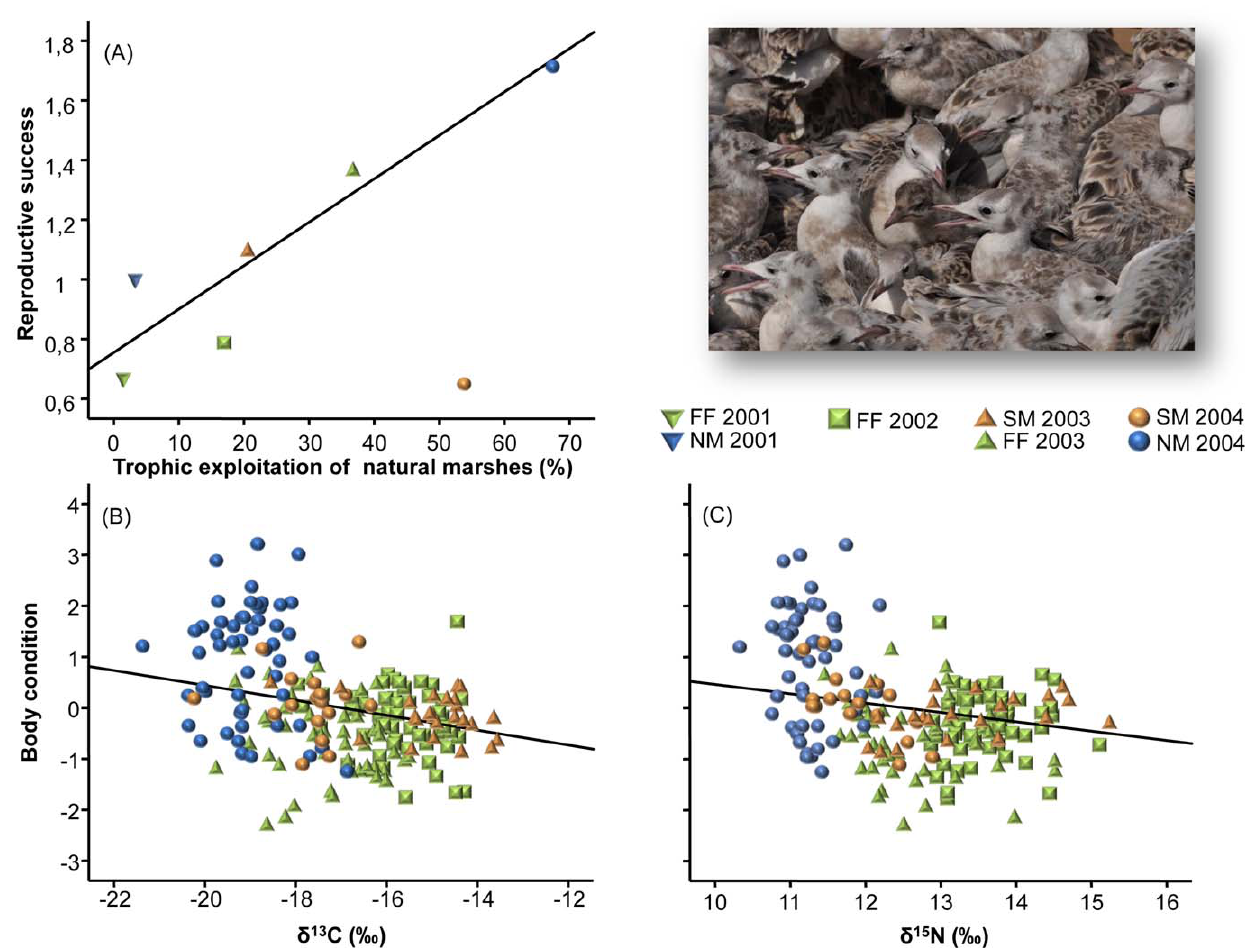
Figure 5. Linking diet with reproductive performance. (A) Relationship between estimated trophic exploitation of natural marshes (in %) by Slender-billed Gulls feeding chicks and the reproductive success of the population (split by breeding season and breeding site: saltmines of Sanlu´car - SM-, fish farm of Veta la Palma -FF- and natural marshes of Don˜ana -NM-). An unusual flooding episode caused a massive mortality of fledglings at SM 2004, and data on breeding success has been excluded from the regression. (B and C) relationships between raw isotopic values ( d 13 C and d 15 N, in % ) for fledglings’ blood and estimated body condition (residuals of the relationship body size-body weight). Morphometric data for the 2001 breeding season were not available, thus making impossible the estimation of fledglings’ body condition. Picture courtesy of M.